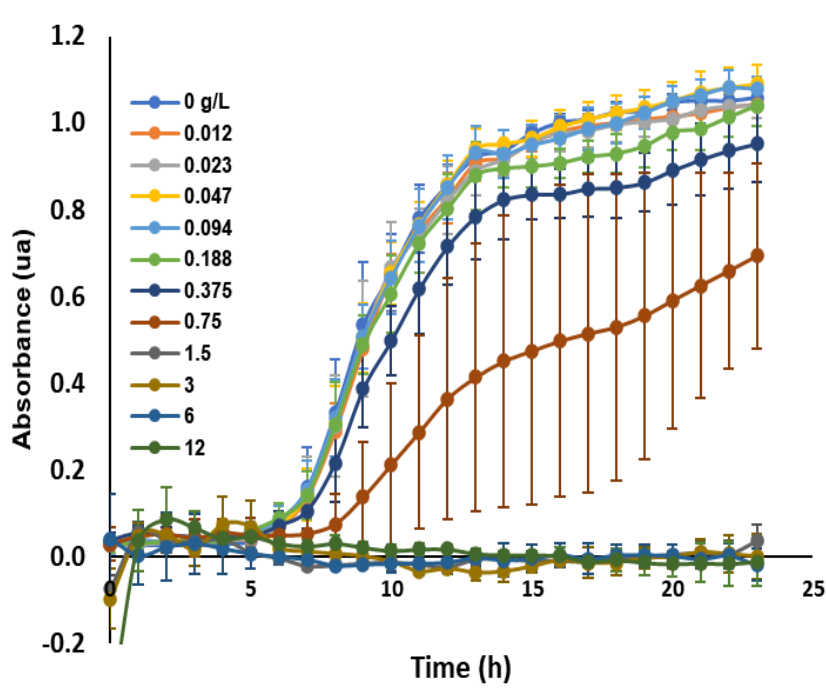
Figure 15. Growing bacteria in the presence of (MIC) of PDA-ZnO-CMCs-HEC.